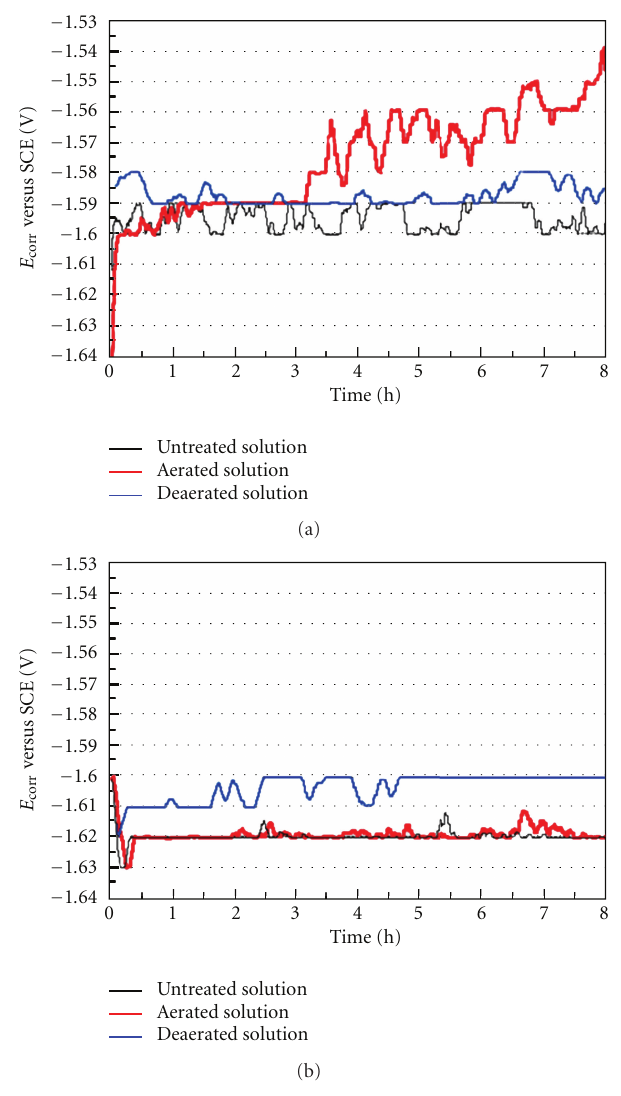
Figure 1: Time variation of E corr for (a) AZ91D and (b) AZ91E in untreated, aerated, and deaerated 5% NaCl solution saturated with Mg(OH) 2 at pH 9 and 25 ◦ C.